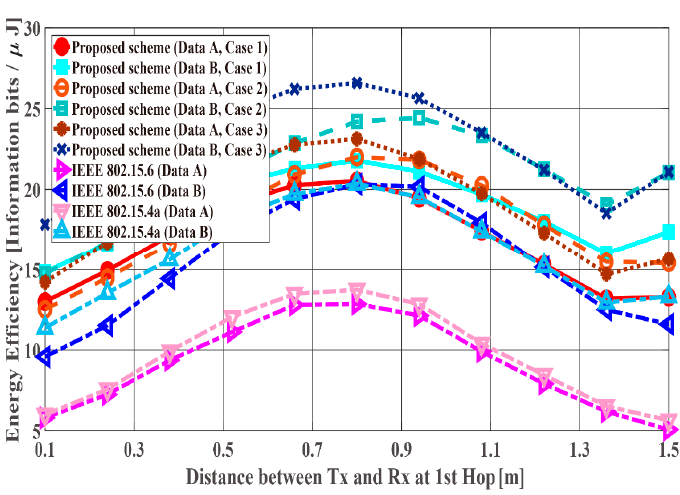
Figure 15. Energy efficiency with constant (cid:1856) (cid:2870)(cid:3035)(cid:3042)(cid:3043)(cid:3046) .